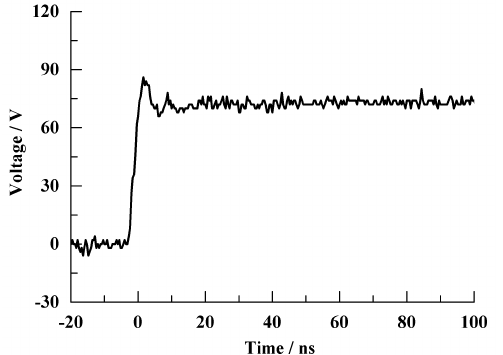
Figure 11. Output of the step voltage generator.